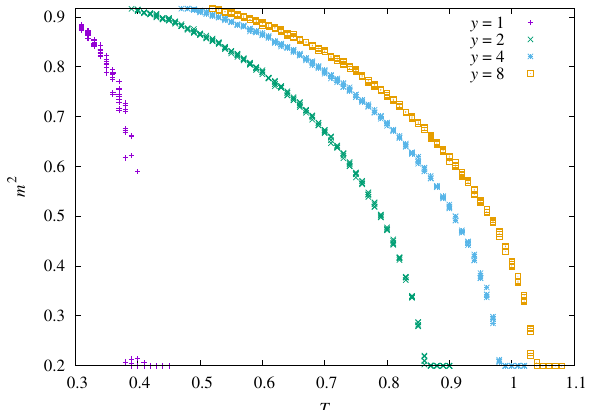
FIG. 17. Squared magnetization defined as in Eq. (E1) of the fixed point reached by BP initialized near a planted glassy state at T , as a function of the planting temperature T for different values of the replicas y at c ¼ 17 , N ¼ 10 4 , γ ¼ 1 . At each temperature, the results for five different planted graphs are shown. T d is located as the lowest temperature at which m 2 ¼ ð 1 =q Þ . As long as y > 1 , the transition becomes